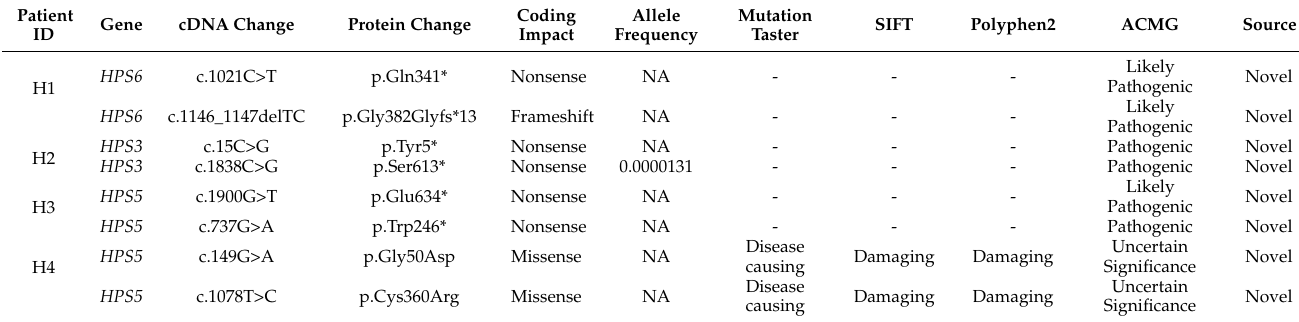
Table 3. Causative mutations identified in the HPS